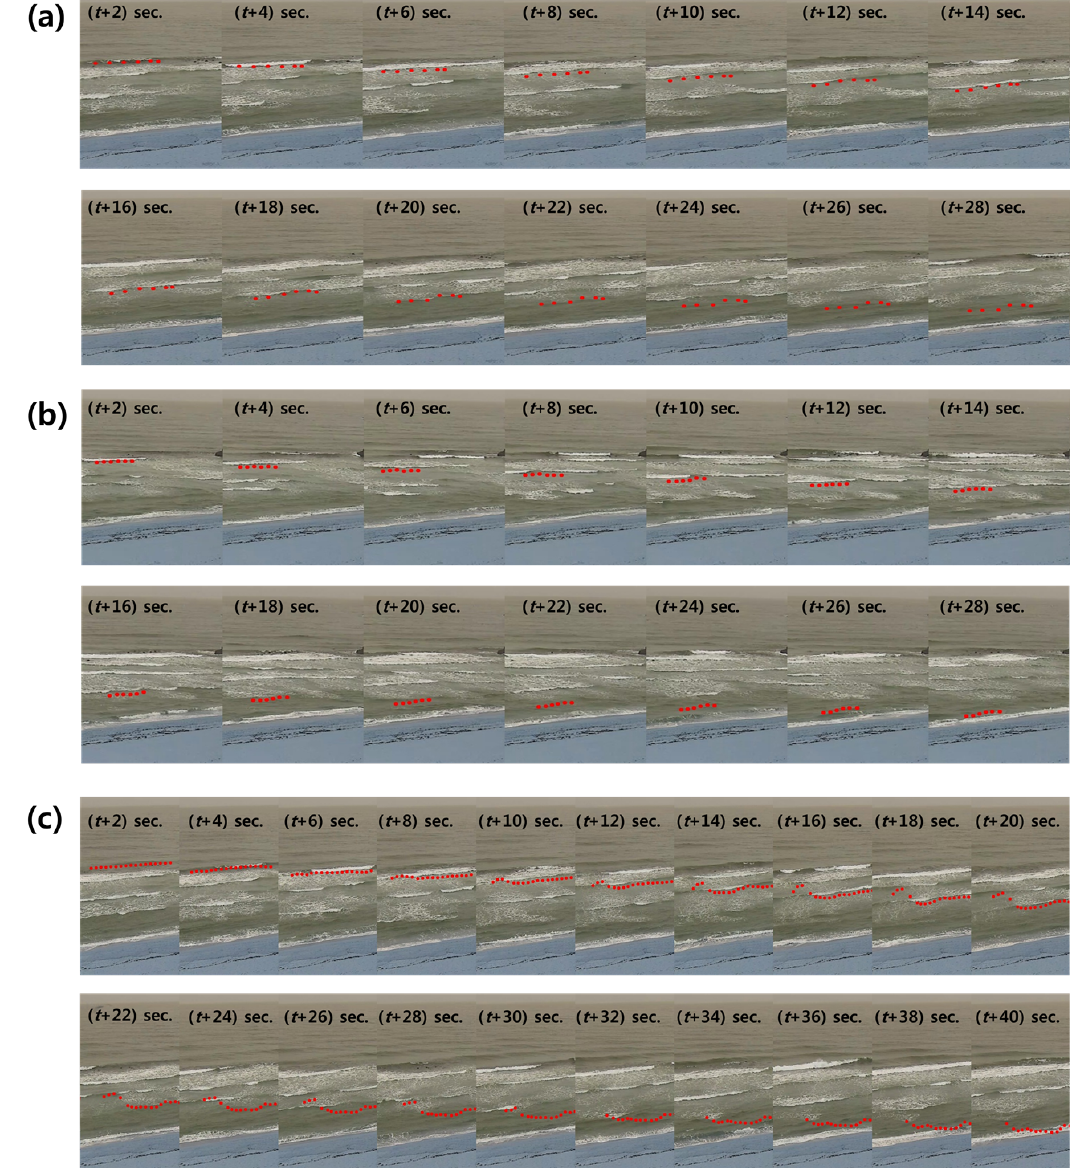
Figure 6. Visualization of wave-tracking by placing circles filled with red color along the wave crest line on the image sequences of propagated waves from left to right with 2 sec. time interval for the 3 test video clips of ( a – c ) taken at 17:00 7 November